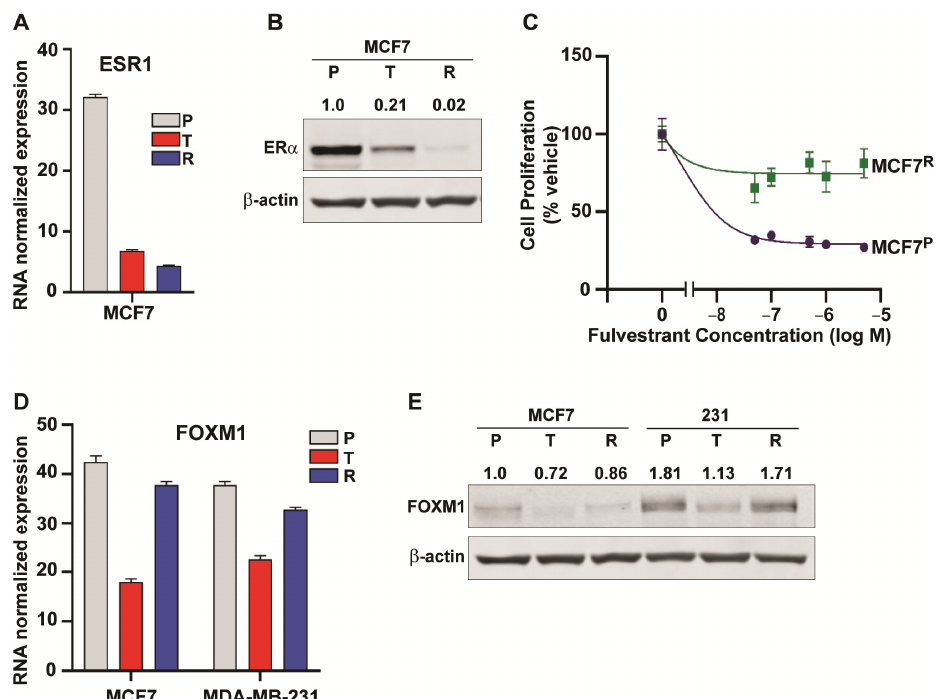
Figure 4. ESR1 and FOXM1 in parental, 24 h inhibitor treated, or resistant breast cancer cells. ( A ) ESR1 RNA expression in MCF7 P, T, and R cells. ( B ) Analysis of ER α protein by Western blot in MCF7 P, T, and R cells. Numbers above the blot indicate level corrected for loading control β -actin. Level in MCF7 P cells is set at 1.0. ( C ) Sensitivity to Fulvestrant in parental MCF7 P cells and in FOXM1 inhibitor resistant MCF7 R cells. Dose–response curves for inhibition of cell proliferation by Fulvestrant are shown. ( D ) FOXM1 RNA expression in MCF7 and in MDA-MB-231 P, T, and R cells. ( E ) Analysis of FOXM1 protein level by Western blot. Numbers above the blot indicate level corrected for the loading control β -actin. Original blots see Figure S3. Level in MCF7 P cells is set at 1.0.